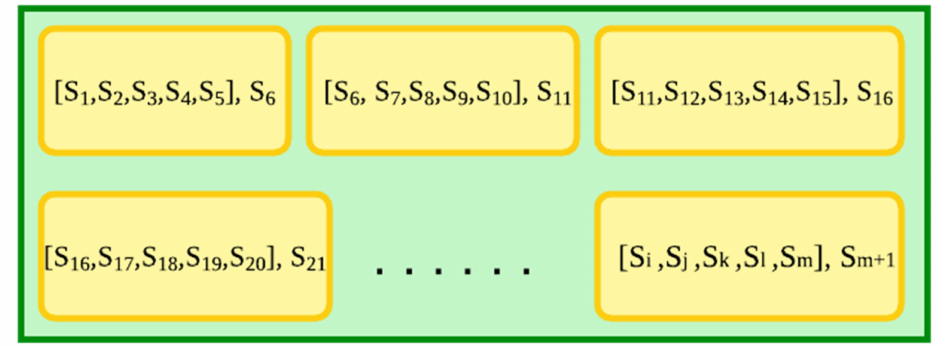
Figure 10. Structure of data frame fed to LSTM model in the